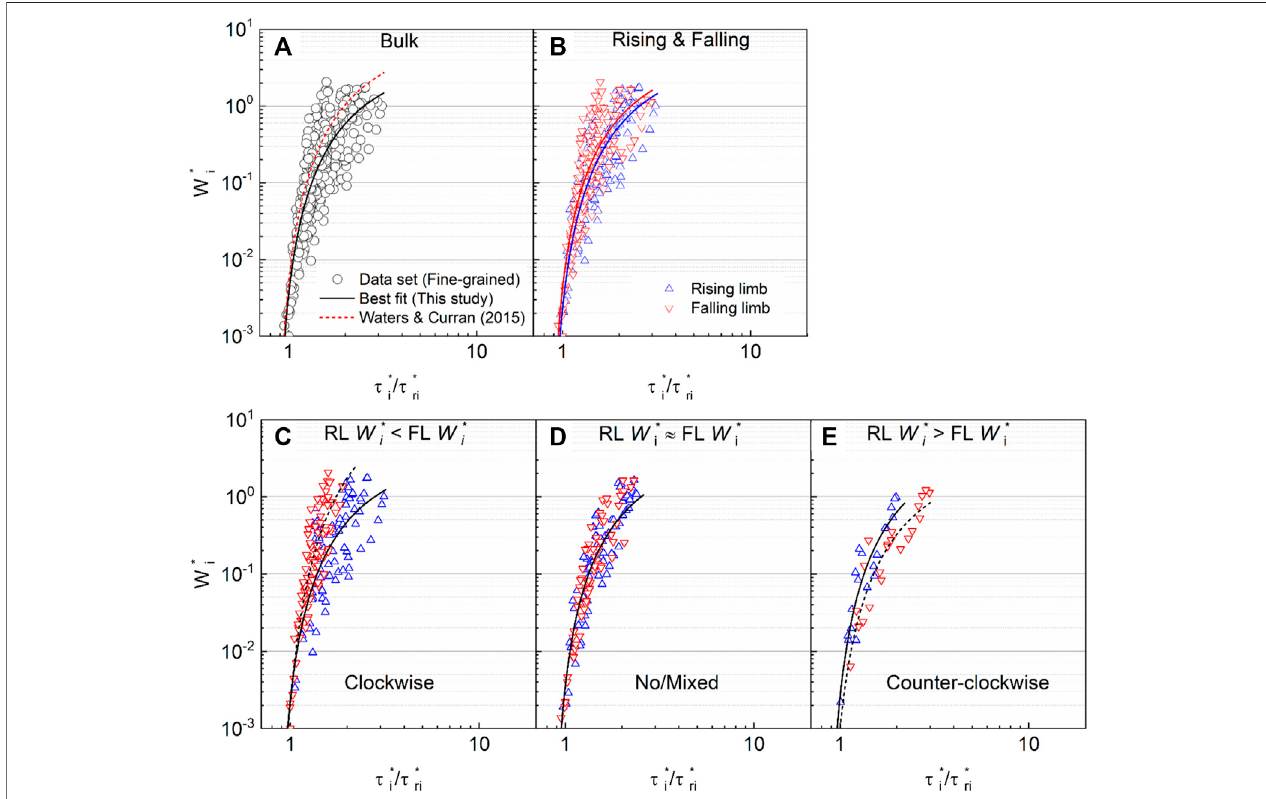
FIGURE 11 | Functional relationship between dimensionless bed load transport W i * and Shields stress ratio τ i */ τ ri * developed for (A) bulk transport dataset (i.e.,representedbyblacksolidanddashedline), (B) separate-limbdataset(i.e.,alltransportdataonseparaterisingandfallinglimbs), (C) datasetswhererising-limb(RL) W* i values < falling-limb (FL) W* i values (i.e., all transport data for CW hysteresis), (D) datasets where rising-limb (RL) W* i values ≈ falling-limb (FL) W* i values (i.e. all transport data with N/M hysteresis), and (E) rising-limb (RL) W* i values > falling-limb (FL) W* i values (i.e. all transport data with CCW hysteresis).